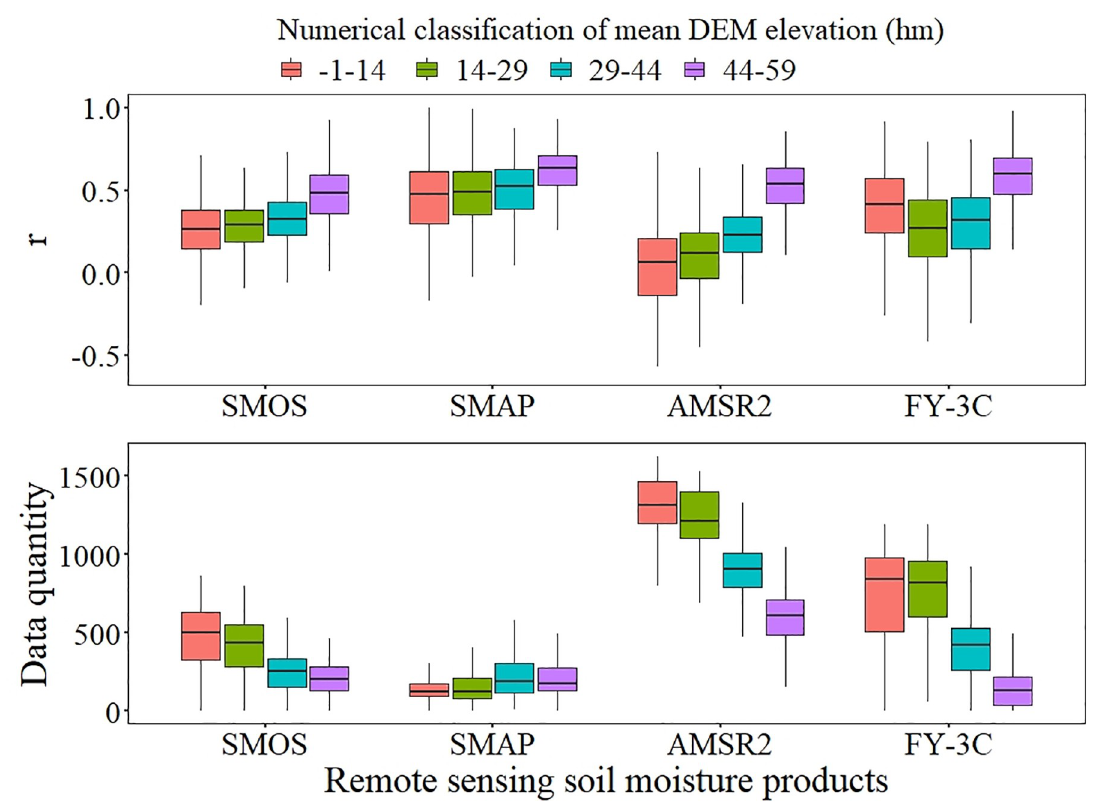
Fig 2. Boxplots of mean DEM elevation for r and data